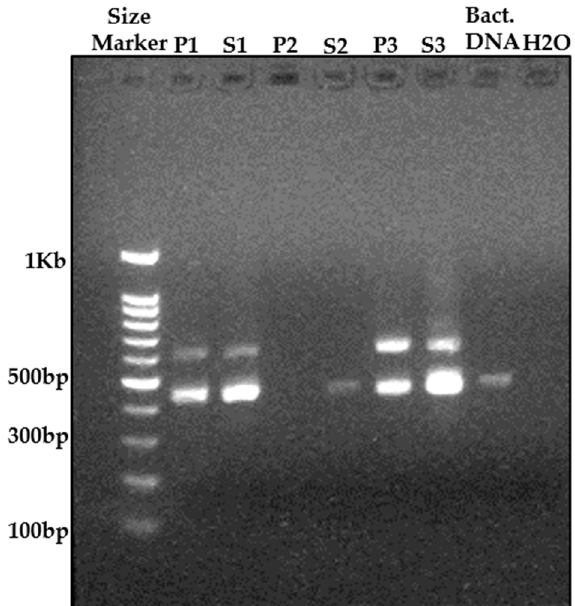
Figure 1. Agarose gel electrophoresis of 16S rRNA gene V4 & V5 regions of PCR products to compare different methods of extracting genomic DNA from soil bacteria. The different combinations of growing media and extraction methods are as follows: P-Sample collected from Ornithogalum dubium grown in perlite during the first growing season. S-Sample collected from O. dubium grown in planting mix in the second growing season. Bact. DNA-Positive control, mixture of E. coli k12 and Pectobacterium brasiliense (Pb3) mixed with planting-mix substrate. H 2 O-used as negative control for the PCR reaction. The extraction methods are numbered: 1-Phenolic extraction protocol. 2-Extraction with C-TAB only. 3-MN Nucleospin Soil Kit. The samples were taken from plot DA3 (repeat #3, water control treatment).